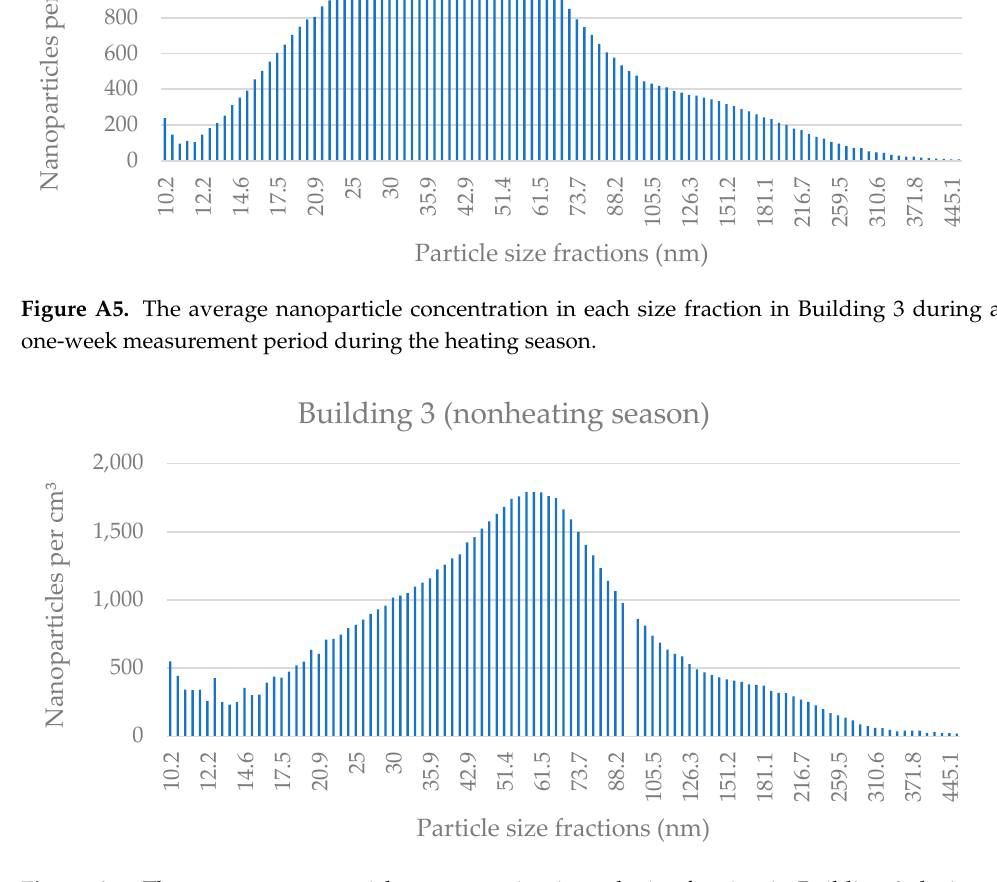
Figure A6. The average nanoparticle concentration in each size fraction in Building 3 during a one-week measurement period during the nonheating season.